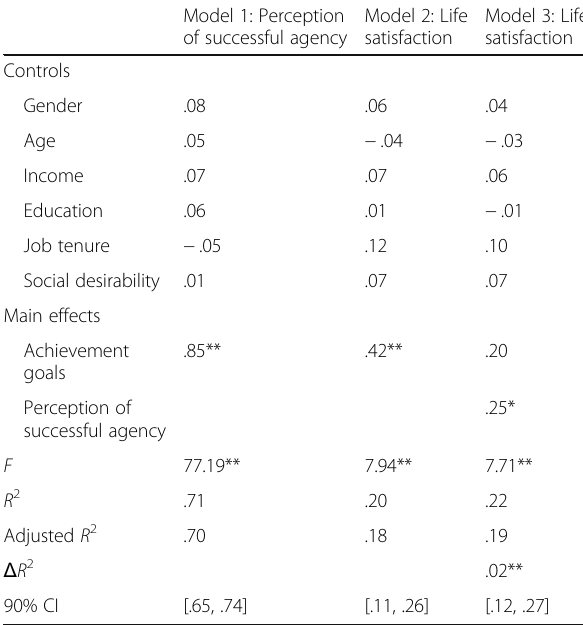
Table 3 Results for main effect and mediation from hierarchical regression